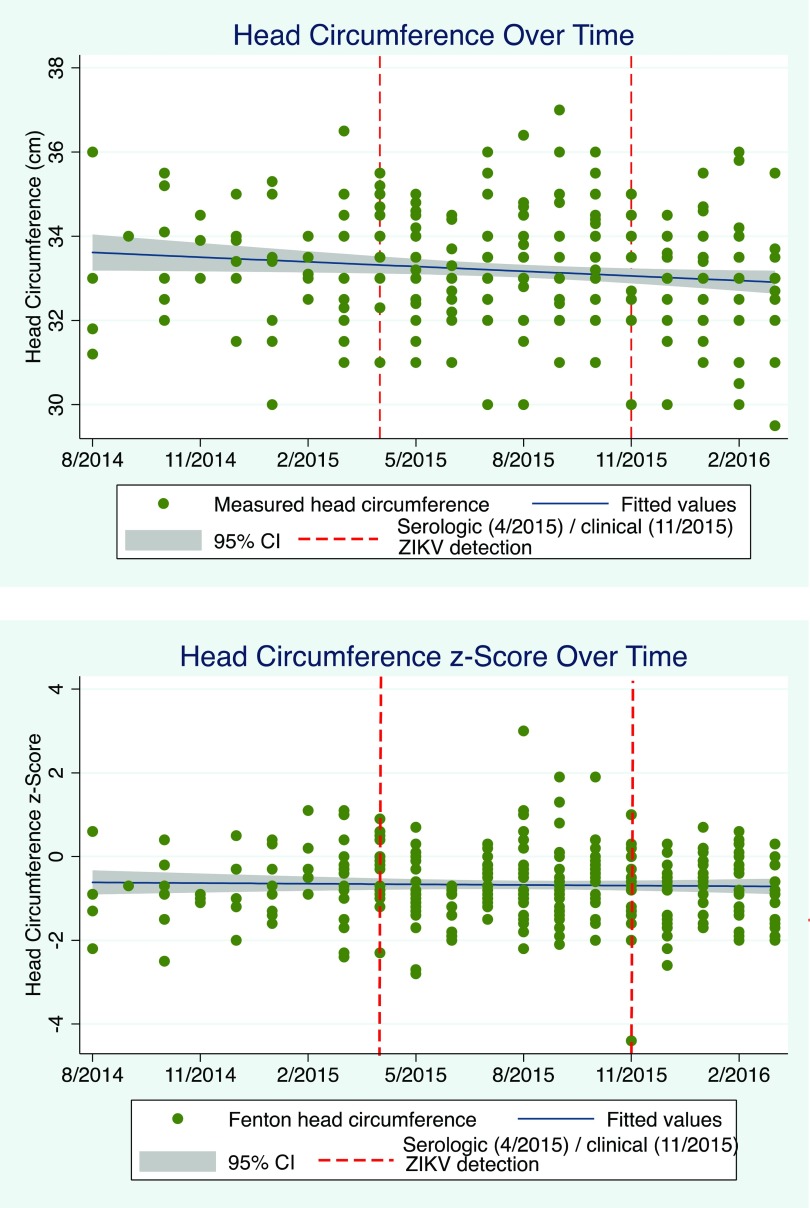
Measured Head Circumference and Z-Score for All Infants by Month of Birth